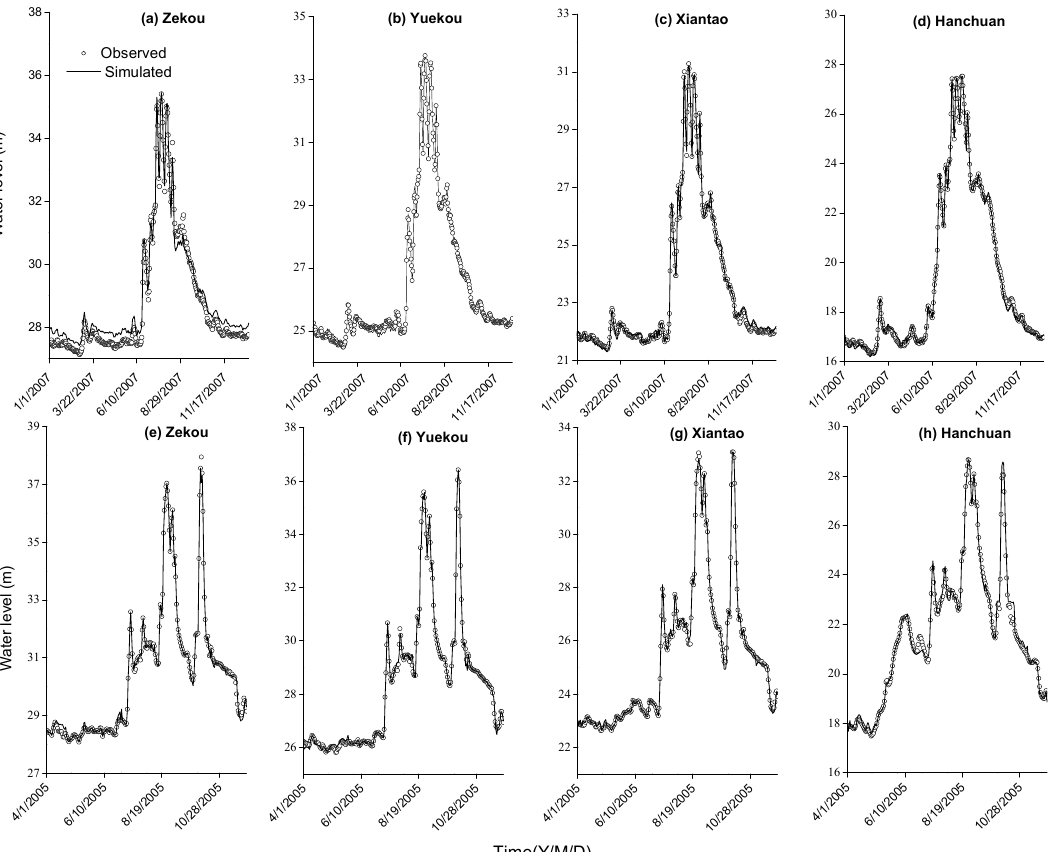
Figure 3. Calibration and validation results of water level at the different gauging stations along the lower Han River channels. The flow processes in 2007 is used for model calibration and the one in 2005 is for model validation.